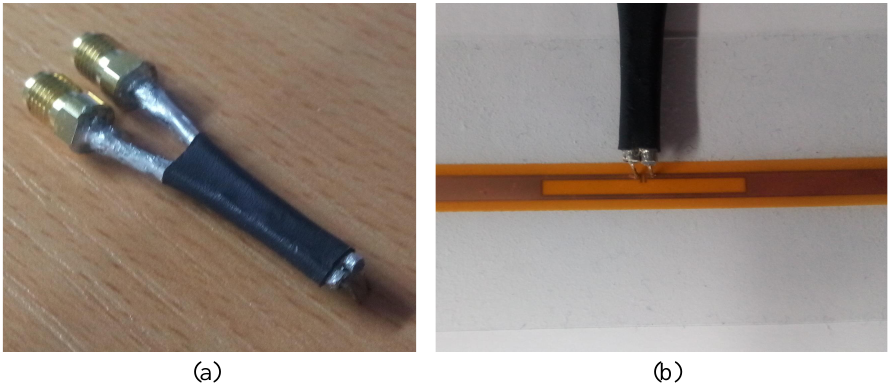
Figure 7. Photographs of the coaxial jig used to measure the antenna’s impedance ( a ) and the coaxial tips landing ( b ).